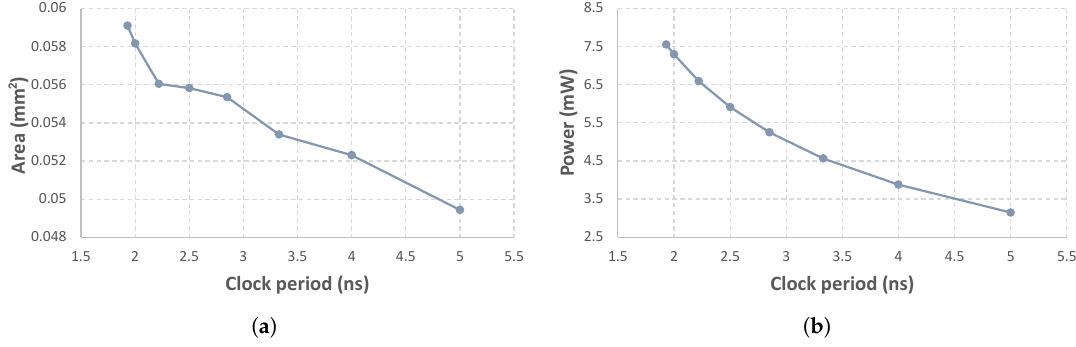
Figure 7. Standard-cell-based ASIC accelerator of the LeNet inference engine: variation of area and power consumption with respect to the synthesis clock, starting from the critical path delay (1.93 ns). ( a ) Total area; ( b ) Mean total